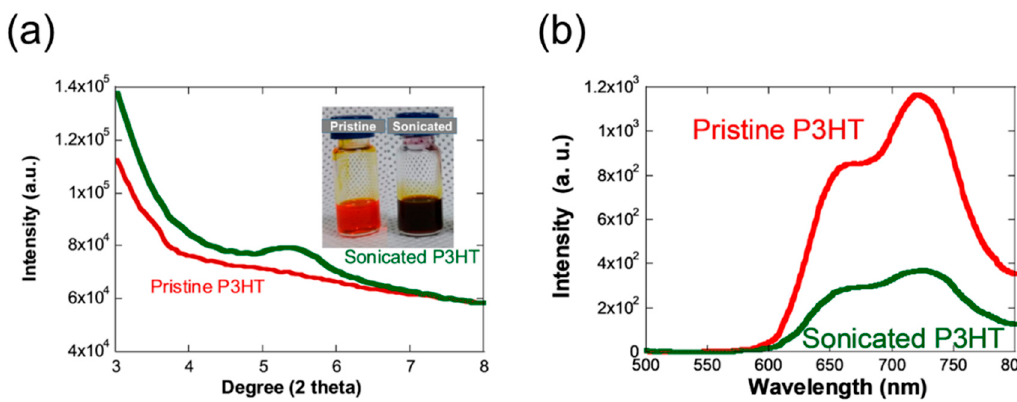
Figure 1. ( a ) grazing incidence X-ray diffraction (GIXD) data of the pristine and sonicated poly(3-hexylthiophene) (P3HT) films prepared by spin-coating of a P3HT solution (5 mg/mL, chloroform). The inset shows the image of the pristine (bright orange) and sonicated (dark brown) P3HT solutions. ( b ) Comparison of the photoluminescence (PL) intensity of the pristine and sonicated P3HT films. The spin-coated P3HT film thickness is estimated to be 90 nm.